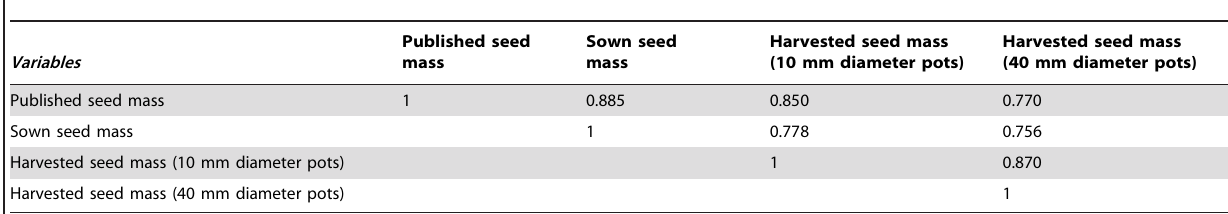
Table 1. Correlations (all significant at P , 0.0001, n =30) between the mean seed mass recorded for each line in a previously published study (Alonso-Blanco et al., 1999), seeds obtained from the Arabidopsis centre TAIR (sown seed mass) and seeds produced in the experiment reported here (harvested seed mass) in two pot sizes.